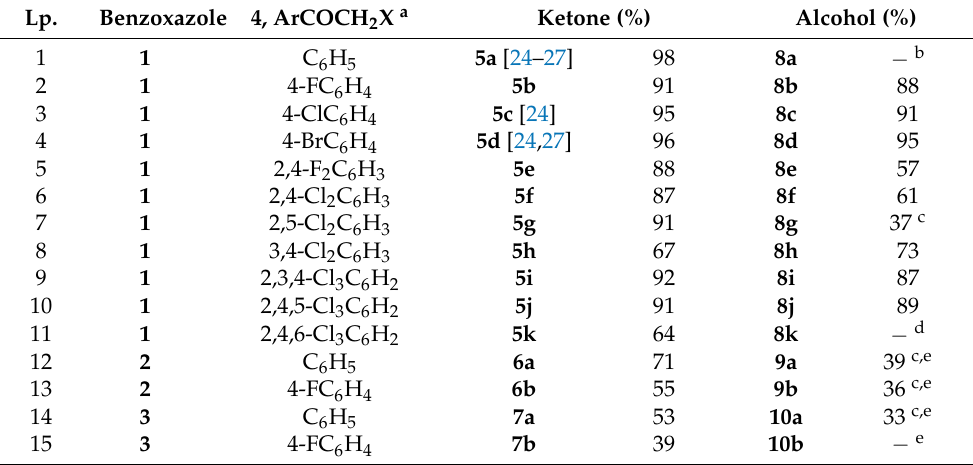
Table 1. Yields of ketones 5 , 6 , 7 and alcohols 8 . Lp.